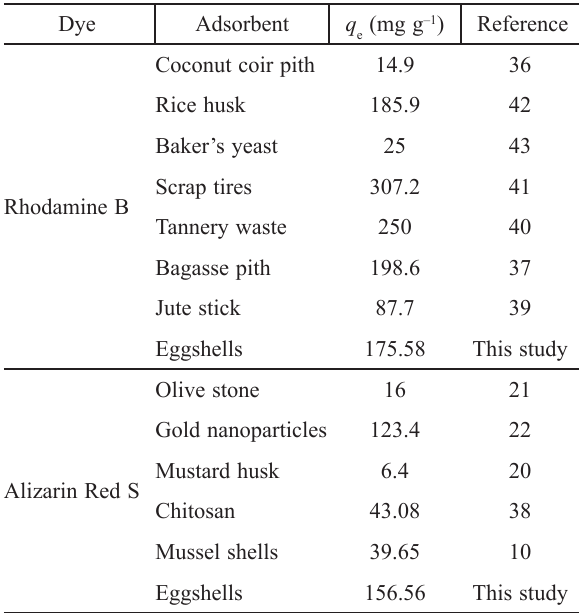
Table 7 – Comparison of adsorption capacities for Rhoda ­ mine B and Alizarin Red S on various